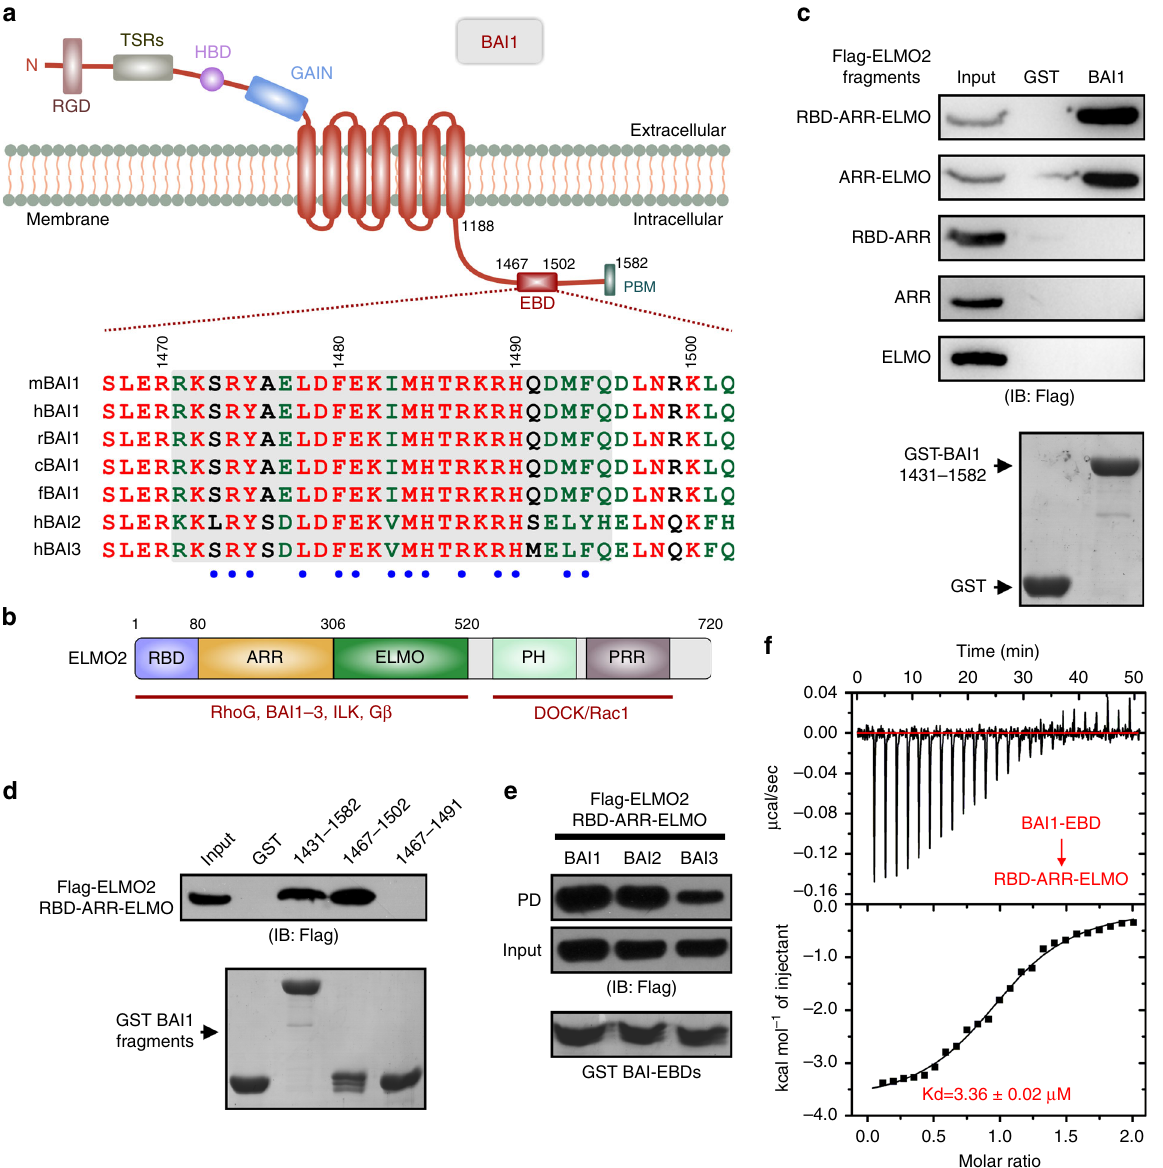
Fig. 1 An intracellular fragment of BAI1 is speci fi cally recognized by ELMO2. a Domain organization of BAI1. RGD, Arg-Gly-Asp integrin-binding motif; TSR, thrombospondin type 1 repeat; HBD, hormone-binding domain; GAIN, GPCR autoproteolysis-inducing domain; EBD, ELMO-binding domain; PBM, PDZ domain-binding motif. In the drawing, the structure-based sequence alignment of BAI1-EBD from different species and orthologs is shown. The absolutely conserved and conserved residues are colored red and green, respectively. Residues involved in binding to ELMO2 are annotated below as blue dots. The residues with clear electron densities in the structure are highlighted with gray box. b Domain organization of ELMO2. Notably, the N-terminus binds to RhoG, BAIs, ILK, and G β ; The C-terminus binds to the DOCK/Rac axis. c , GST-pull down assays showing that the intact RBD-ARR-ELMO (RAE) tandem of ELMO2 is required for BAI1 recognition. d GST-pull down assays showing that the fragment aa 1467-1502 of BAI1 is the minimal region responsible for ELMO2-RAE binding. e All the BAIs (BAI1, 2, 3) bind to ELMO2-RAE effectively in the GST-pull down assays. PD, pull down. f Quantitative measurement of the binding af fi nity between BAI1-EBD and ELMO2-RAE using the ITC-based